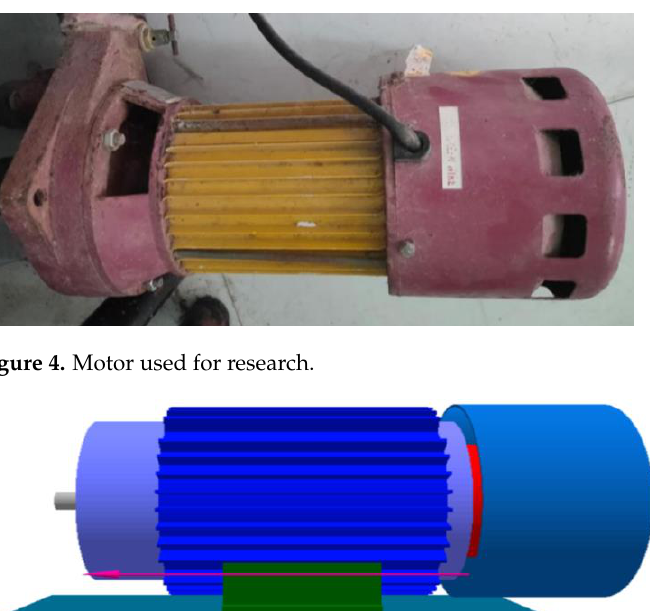
Figure 4. Motor used for research.